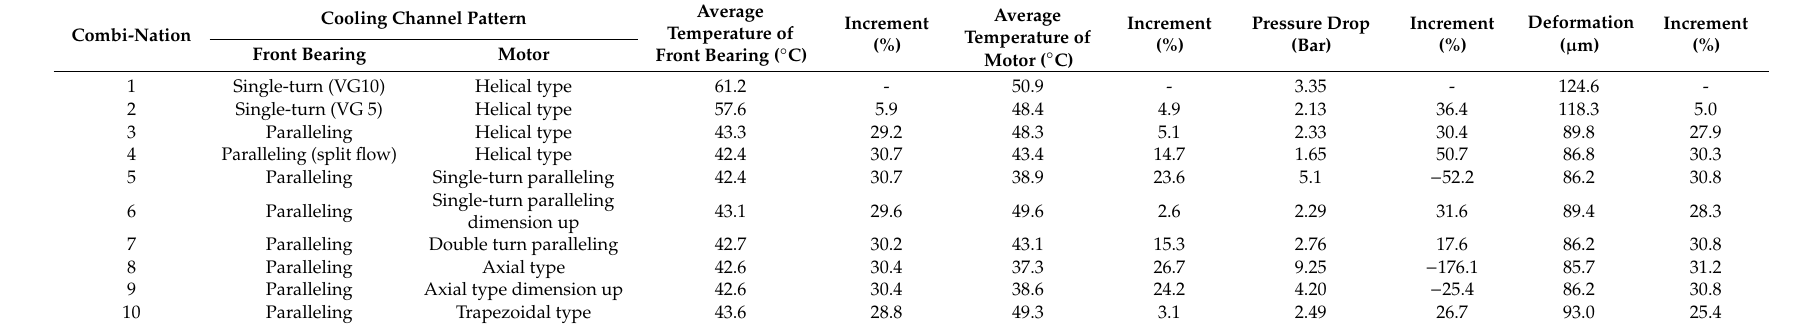
Table 3. Summary of simulation results of spindle thermal deformation and cooling channel pressure